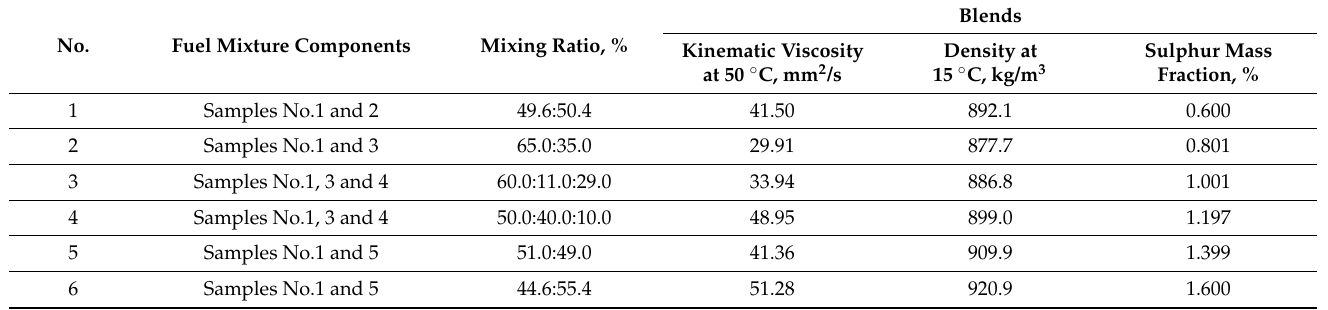
Table 2. Results of fuel blend design